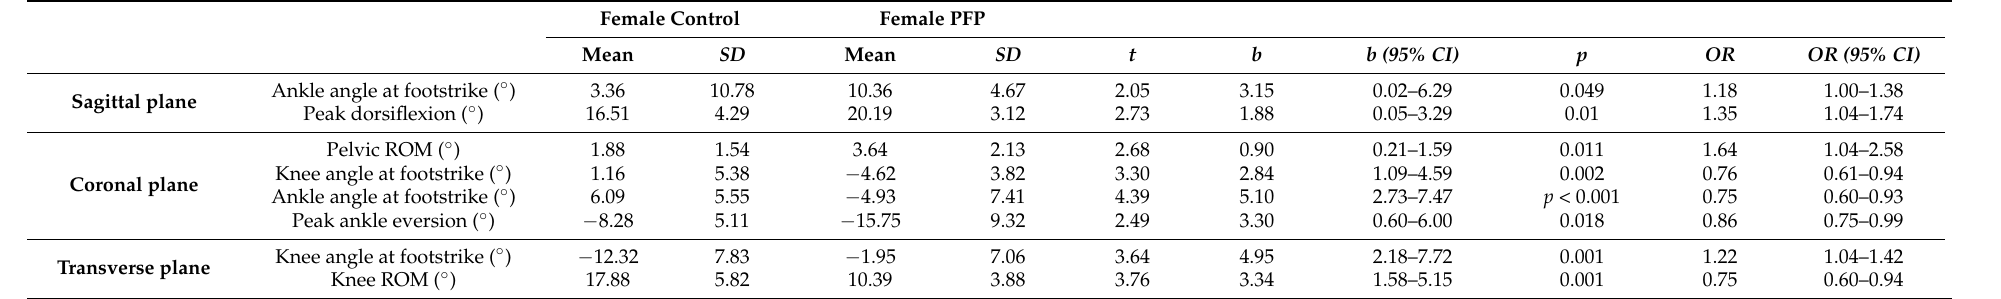
Table 7. Three-dimensional kinematics in female PFP participants and